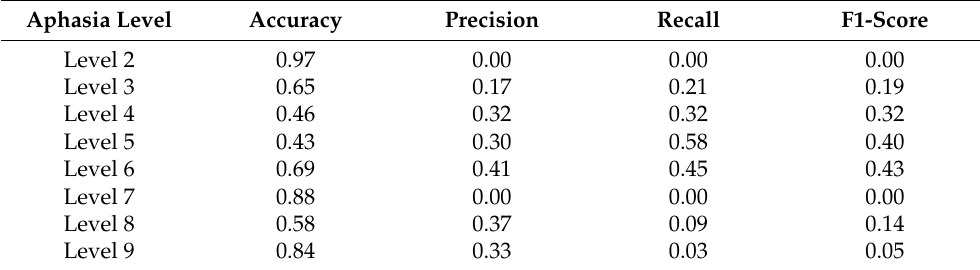
Table 8. Classification report of the DNN model for aphasia level classification using 10 s audio chunks whose features are extracted using the zero crossing